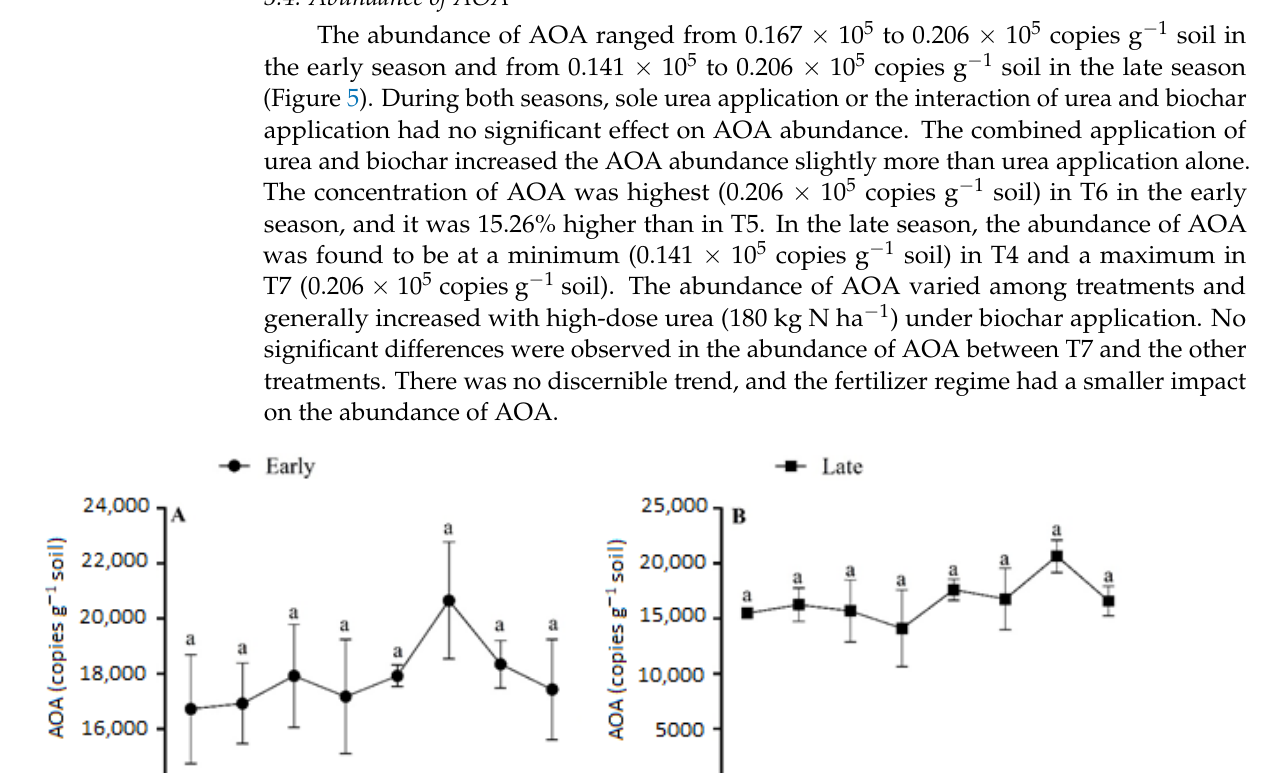
Figure 6. ( A , B ) Concentration of NOB in the early and late seasons under low ‐ and high ‐ dose urea application and different levels of biochar application. Note: Bars with different letters are signifi ‐ cantly different, at p < 0.05.